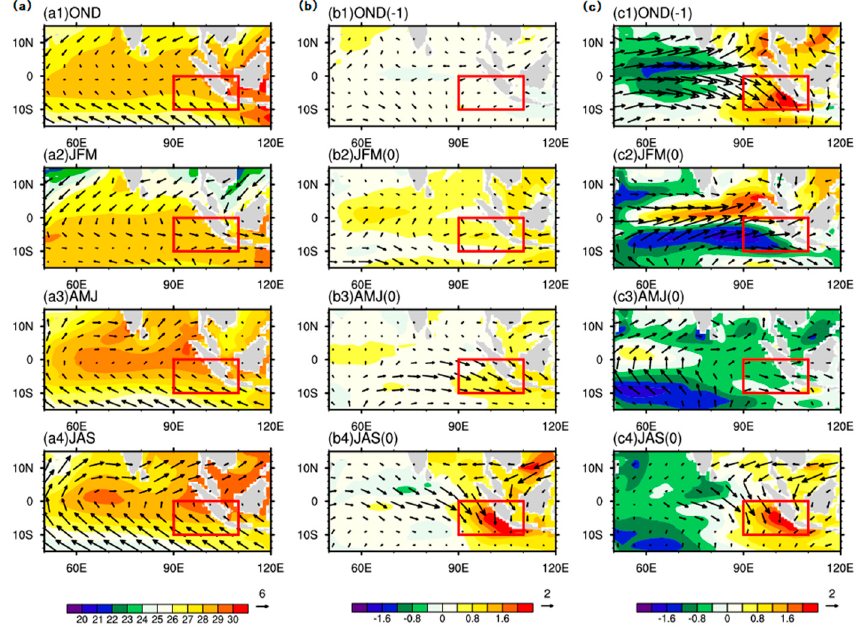
Figure 12. Same as Figure 11, ( a ) for the climatological state, but ( b ) for the pure IOD events and ( c ) for the pIOD events that occurred with El Niño induced by the type-2 initial errors.